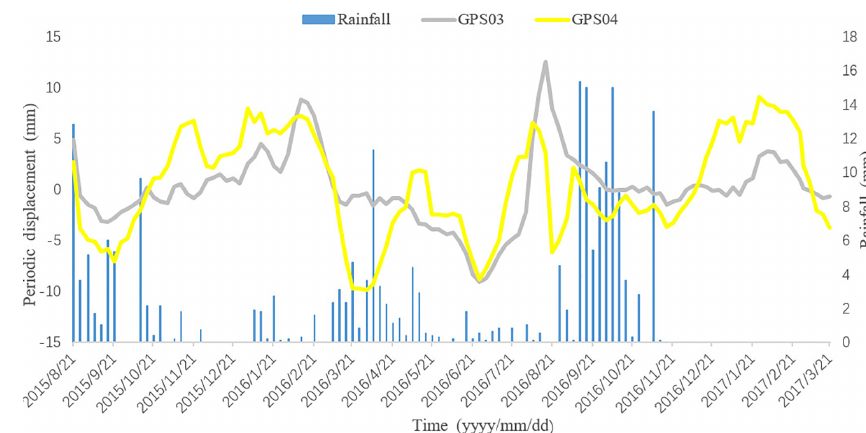
Figure 6. The periodic-term displacement combined with rainfall data in GPS03 and GPS04.